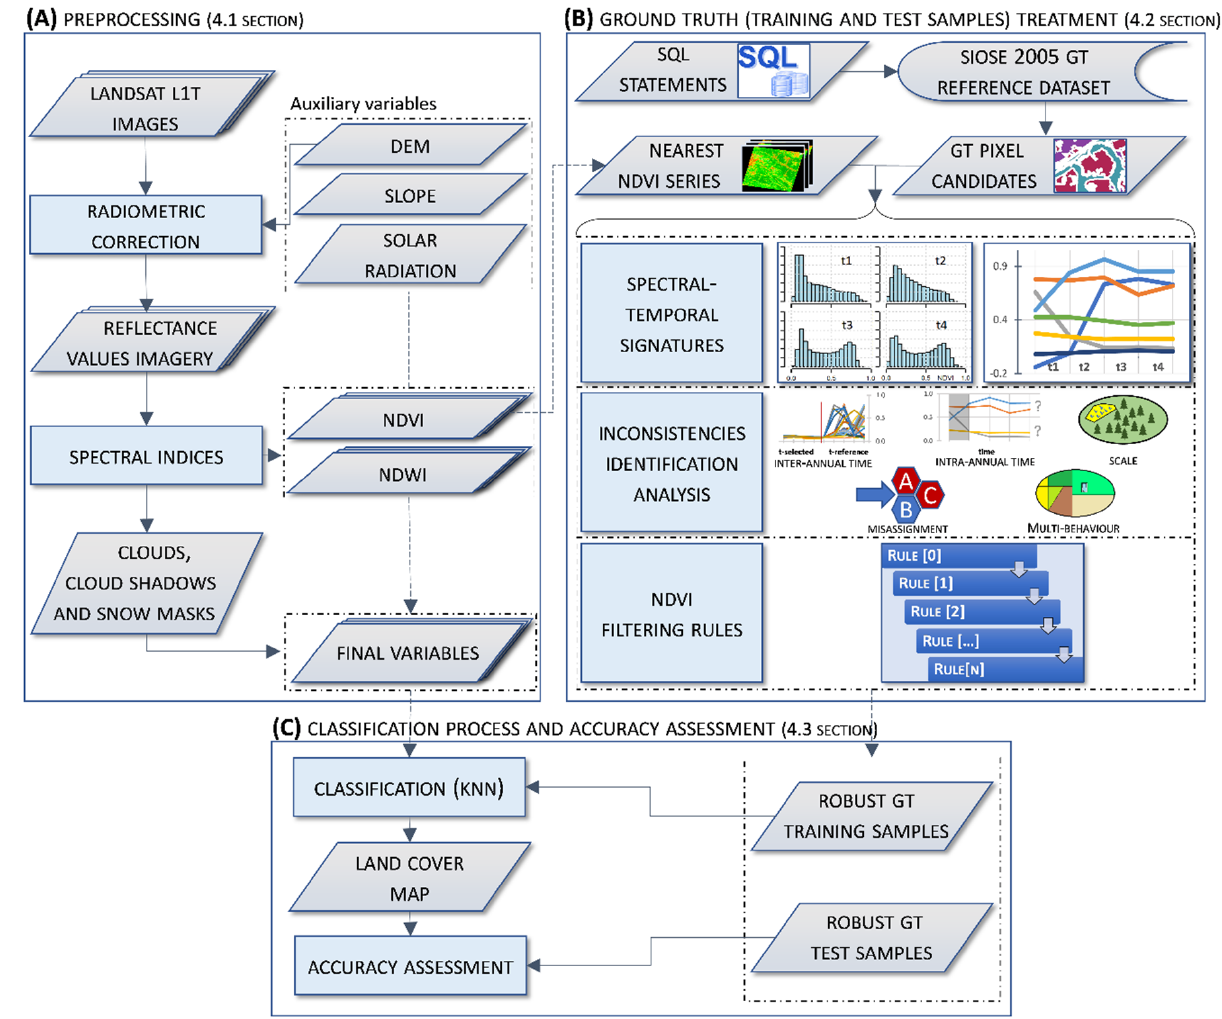
Figure 2. Methodology flowchart. Image pre-processing ( A ) provided the final variables used in the classification process and NDVI series to characterise the spectral-temporal signatures of the different classes. ( B ) Structured Query Language (SQL) statements applied to SIOSE 2005 rDS provided a set of polygon selectors which determined the initial GT candidate pixels. ( C ) The rules applied to GT candidate pixels provided a final set of robust GT samples, segregated into training and test area (TTA) subsets.